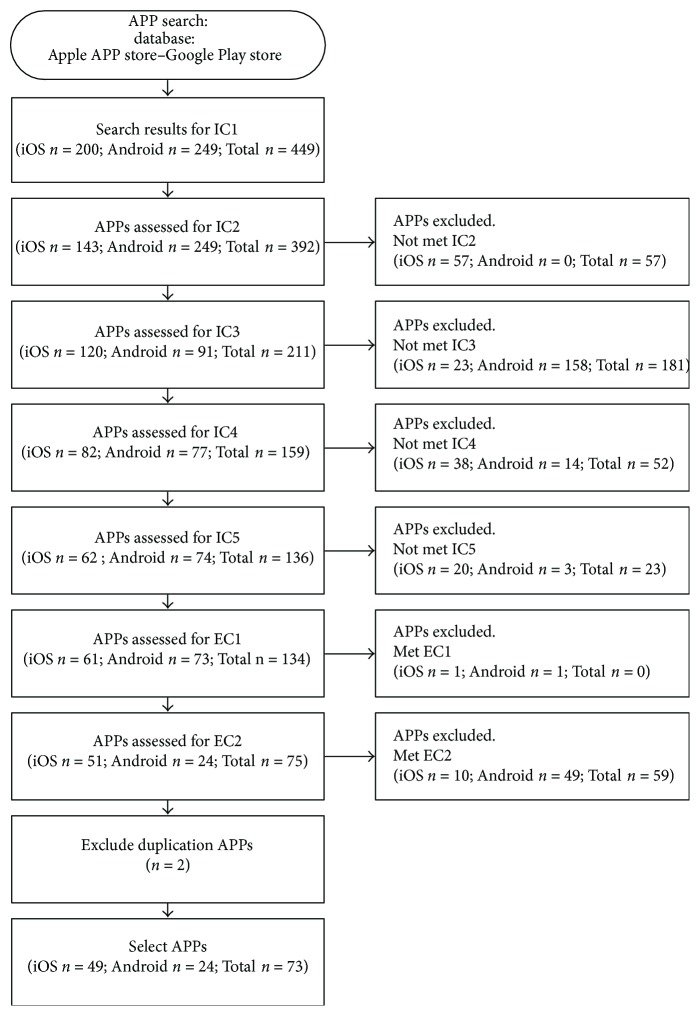
PRISMA flow diagram.